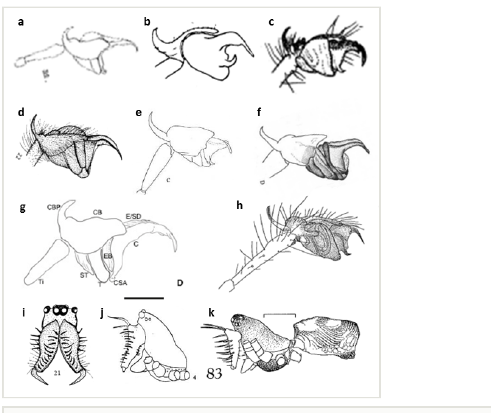
Figure 1. Selected images from the legacy taxonomic literature depicting the male of purported Opadometa grata (according to the current World Spider Catalog 2018) with notation of geographic location. a-h : pedipalp with attention to the cymbial basal apophysis (CBP, see Kuntner et al. 2008). i-k , male prosoma with attention to the